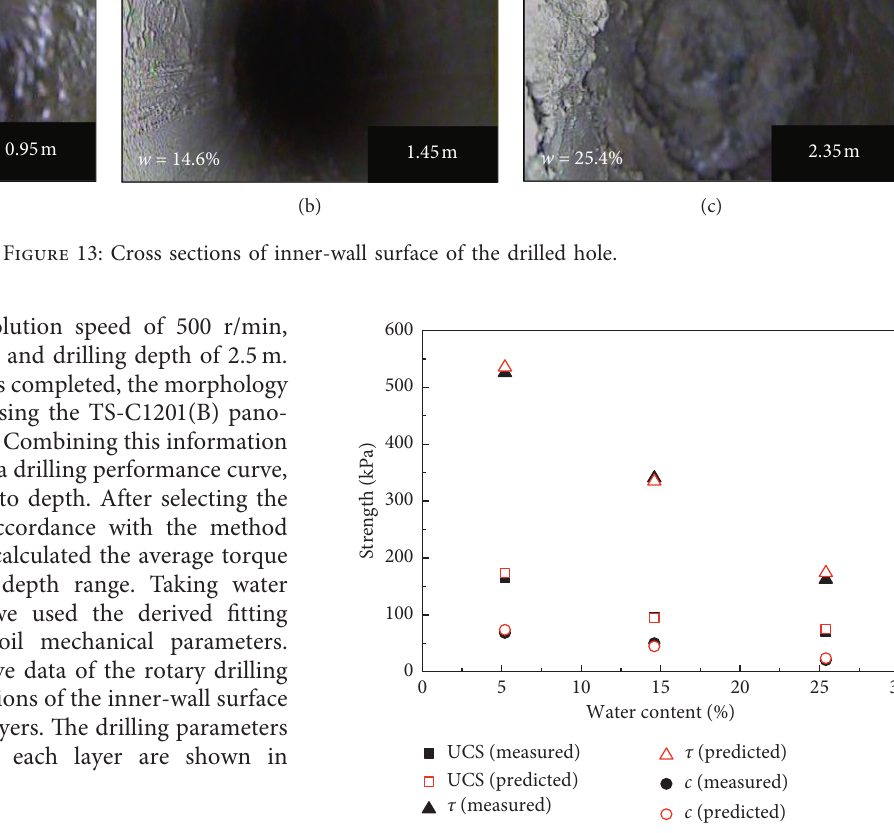
Figure 14: Comparison of test results and predicted